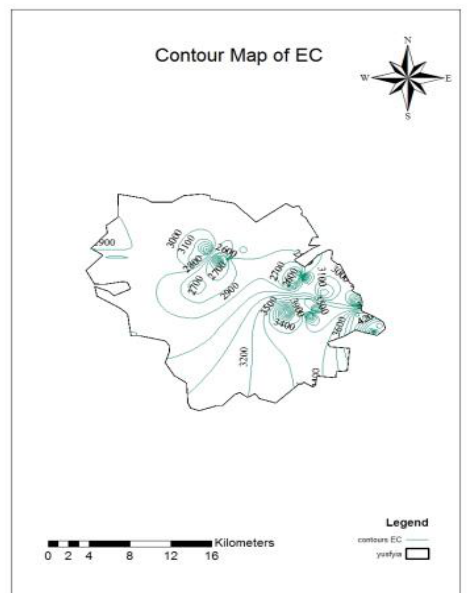
Fig.3: The interpolation and contour line of EC map in μS/cm